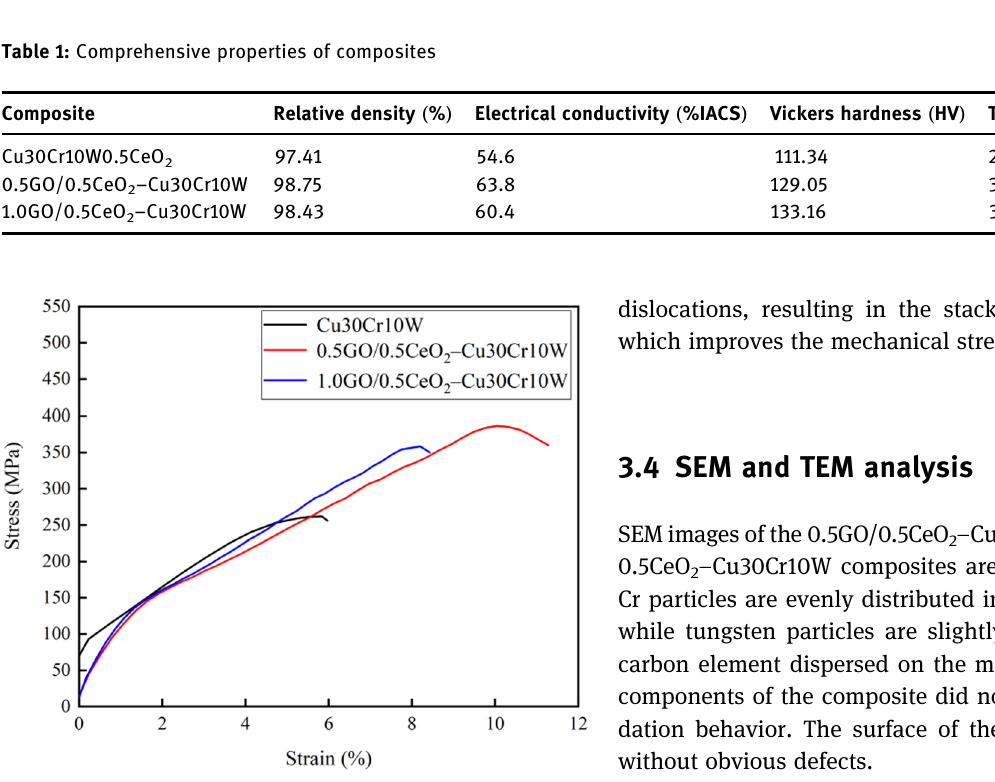
Figure 4: Tensile stress – strain curves of di ff erent